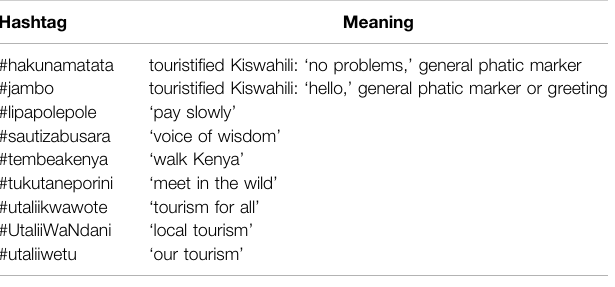
TABLE 3 | Kiswahili hashtags used in the data.